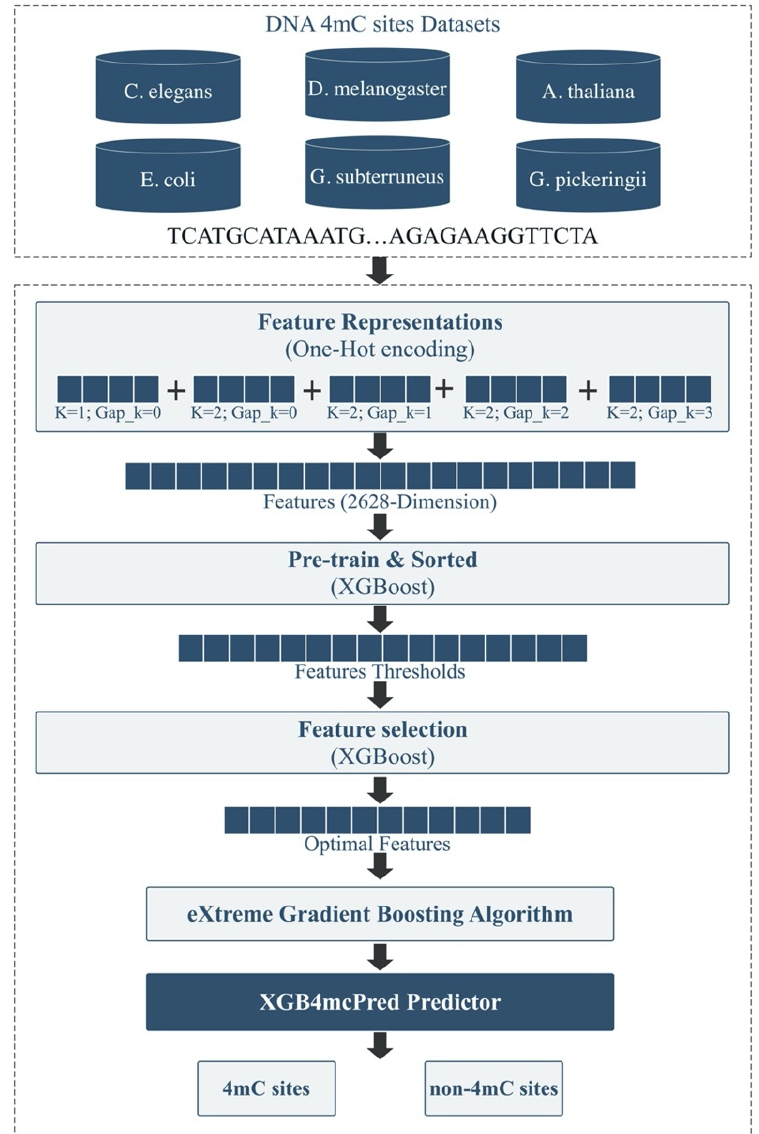
Figure 1. A framework of DNA 4mC site prediction based on the XGB4mcPred predictor.